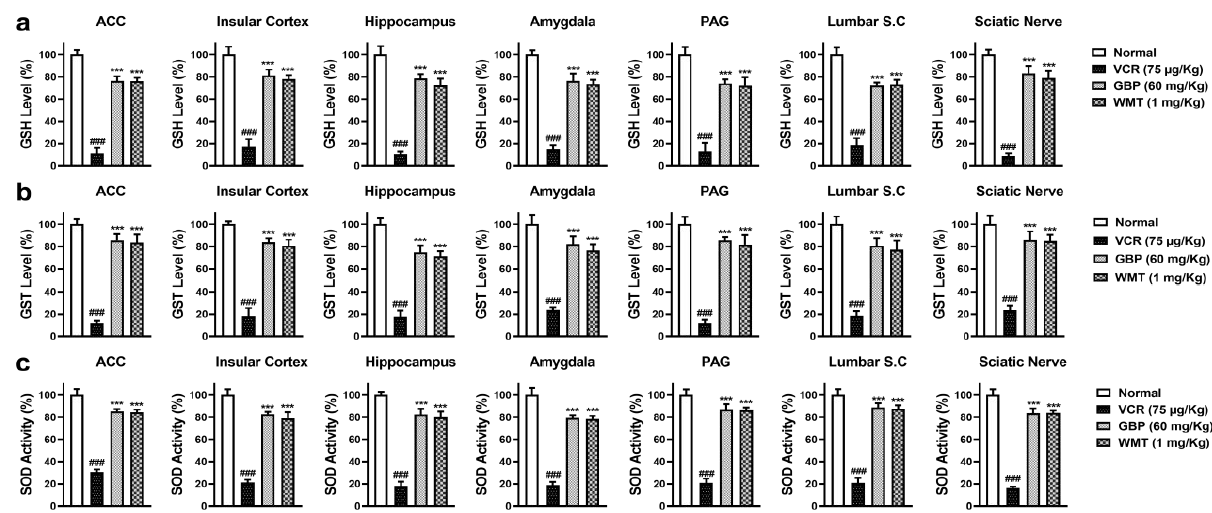
Figure 3. The effect of withametelin on the antioxidant levels in the different regions of the brain, spinal cord, and sciatic nerve of the VCR model. GSH ( a ), GST ( b ), and SOD levels ( c ). The results were expressed in percentages. All results were expressed as the mean ( n = 5) ± SD. The experiment was performed in triplicate independently. ### p < 0.001 compared to the normal control group; *** p < 0.001 compared to the VCR group.